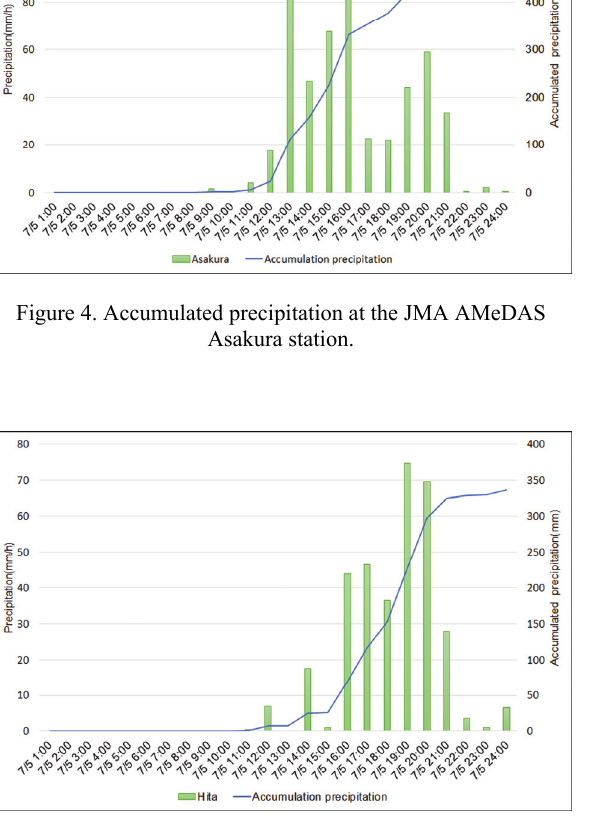
Figure 5. Accumulated precipitation at the JMA AMeDAS Hita